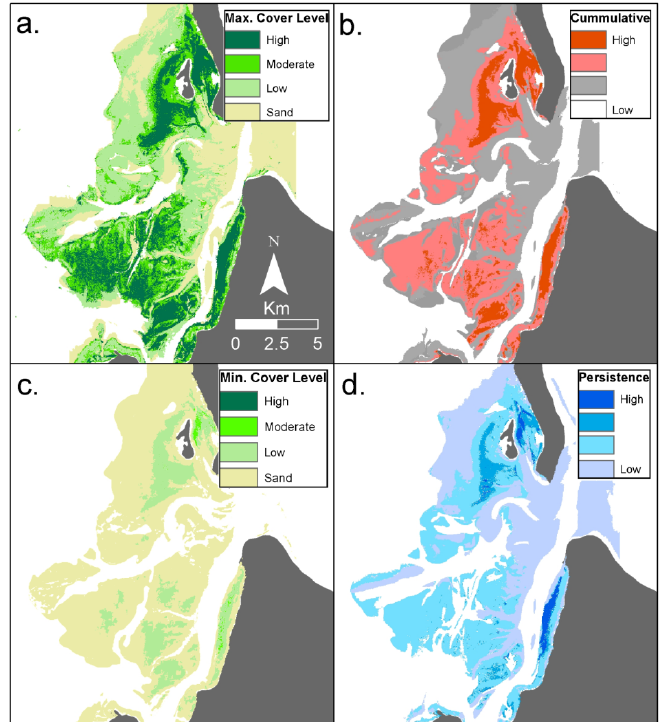
Figure 4. Example of time series analysis for thematic seagrass cover maps for Eastern Banks, Moreton Bay, East coast Australia, derived from twenty two Landsat satellite images on annual basis from 1988–2010. The time series analysis products include maps representing: ( a ) Extent of maximum and ( b ) minimum seagrass cover level; ( c ) Cumulative seagrass cover level and ( d ) seagrass cover level persistence over time (measure of the amount of variation from the most frequently occurring pixel, analogous to standard deviation)